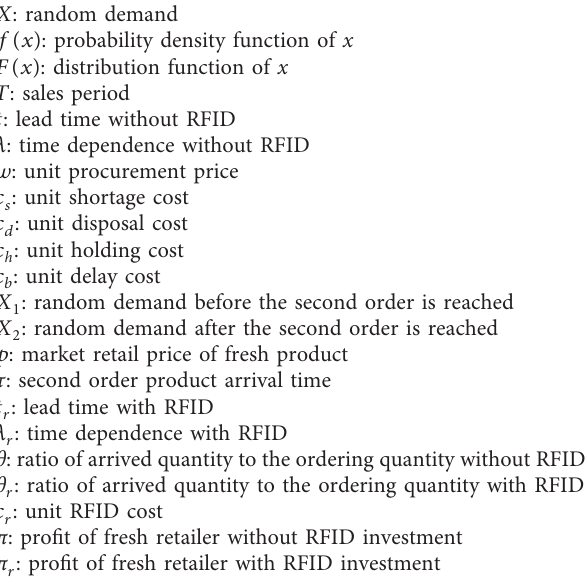
Table 1: The meanings of parameters and